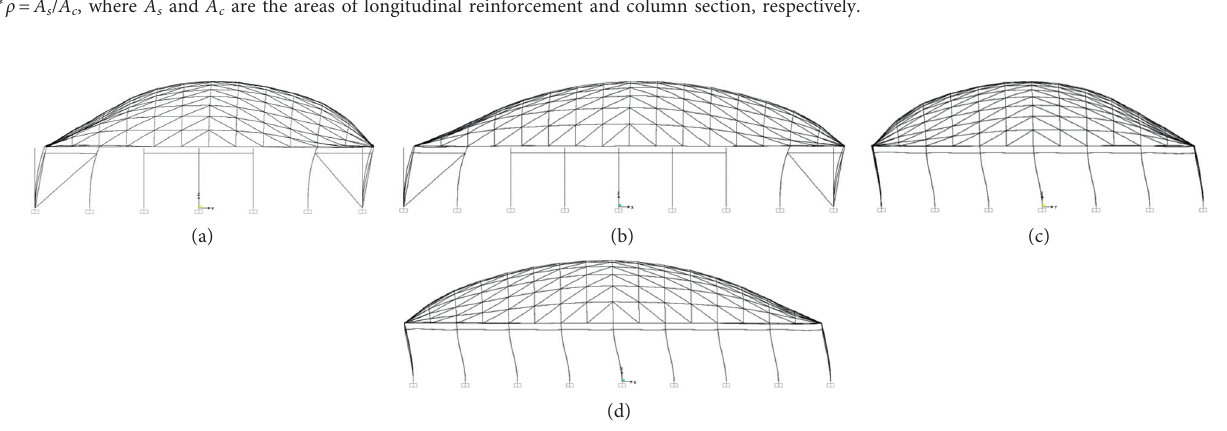
Figure 12: The first two vibration modes. (a) 1st mode of SS-SRC; (b) 2nd mode of SS-SRC; (c) 1st mode of SS-RC; (d) 2nd mode of